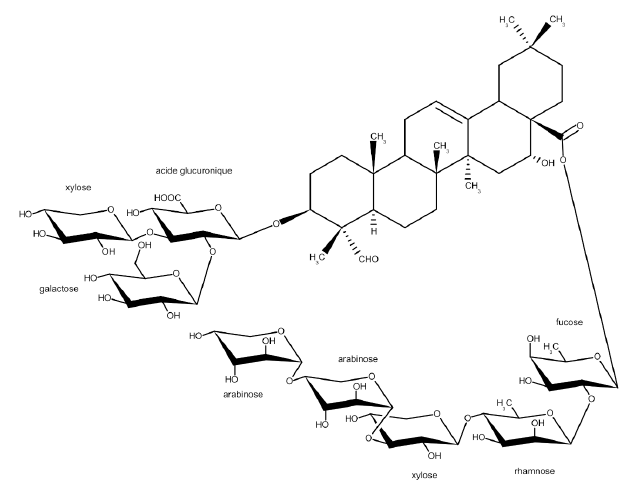
Figure 1. Schematic view of the structure of the GOTCAB saponin from the roots of Gypsophila paniculata L. as determined by